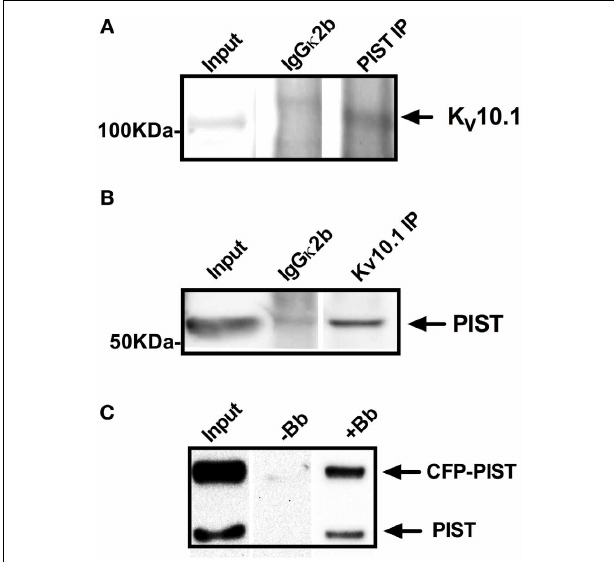
FIGURE 1 | Co-precipitation of K V 10.1 and PIST out of (A,B) rat brain lysates and (C) HEK293_K V 10.1_BBS cells. Specific antibodies against PIST (A) or K V 10.1 (B) were used for precipitation out of rat brain lysates using Protein A/G coupled sepharose beads. Isotype control antibodies served as negative controls. Co-precipitation of Kv10.1 by anti PIST immunoprecipitation (A) as well as precipitation of PIST by anti K V 10.1 immunoprecipitation (B) were detected by western blot. (C) K V 10.1_BBS was labeled with an α -bungarotoxin-biotin conjugate after lysis of HEK293_K V 10.1_BBS cells and pulled down with streptavidin-coated beads. Detection on a western blot with and anti-PIST antibody shows bands compatible with precipitation of both CFP-tagged and endogenousPIST.